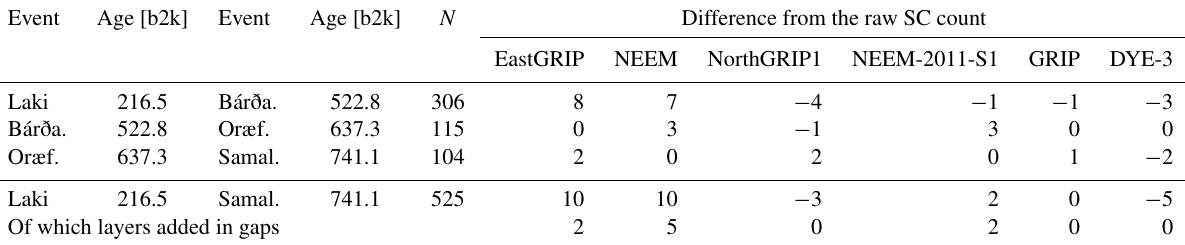
Table 2. Evaluation of the SC bias of each ice core in the timescale sections constrained by historical evidence on eruption ages. The eruptions chosen for the overview were all, except for one, Icelandic: Laki (1783CE), Bárðarbunga (1477CE), Oræfajökull (1367CE), and Samalas (1258CE, Indonesia, considering a 1-year depositional delay). Within each interval, the number of expected layer boundaries is indicated by N . For each ice core, the difference from the raw SC count indicates the amount and direction of bias. A positive value means that SC layers had to be added in order to reach the expected N , while a negative value means that they had to be removed. The longest interval (Laki–Samalas) shows the total layer-modifications required by each ice core. The values indicate that the “CFA cores” (EastGRIP, NEEM, NEEM-2011-S1) are mostly undercounted, partly because of measurement gaps, while the “GICC05 cores” (NorthGRIP1, GRIP, DYE-3) were mostly in need of removing layers. This evaluation of bias is what eventually justifies the fine-tuning process over a purely statistical combination of SC